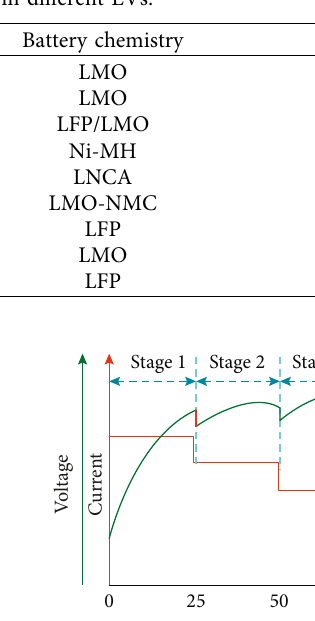
Figure 12: Four-stage constant current (FSCC) charging